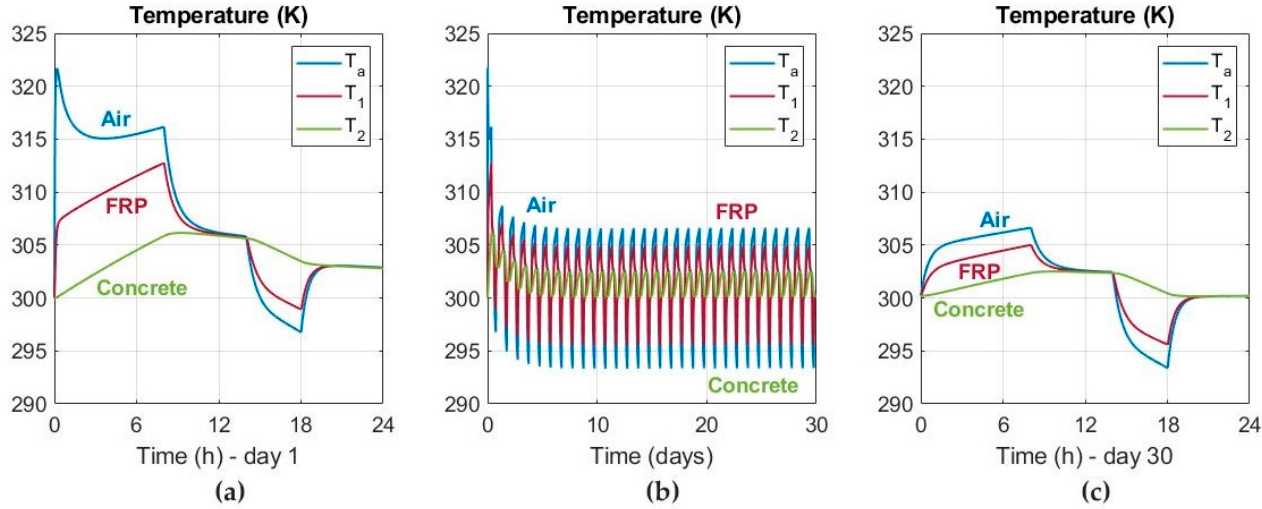
Figure 4. Temperature of air, fiber-reinforced plastic (FRP) and concrete lining for 30 charging and discharging cycles considering FRP as sealing layer. ( a ) First cycle; ( b ) 30 days of operation; ( c ) 30th cycle.